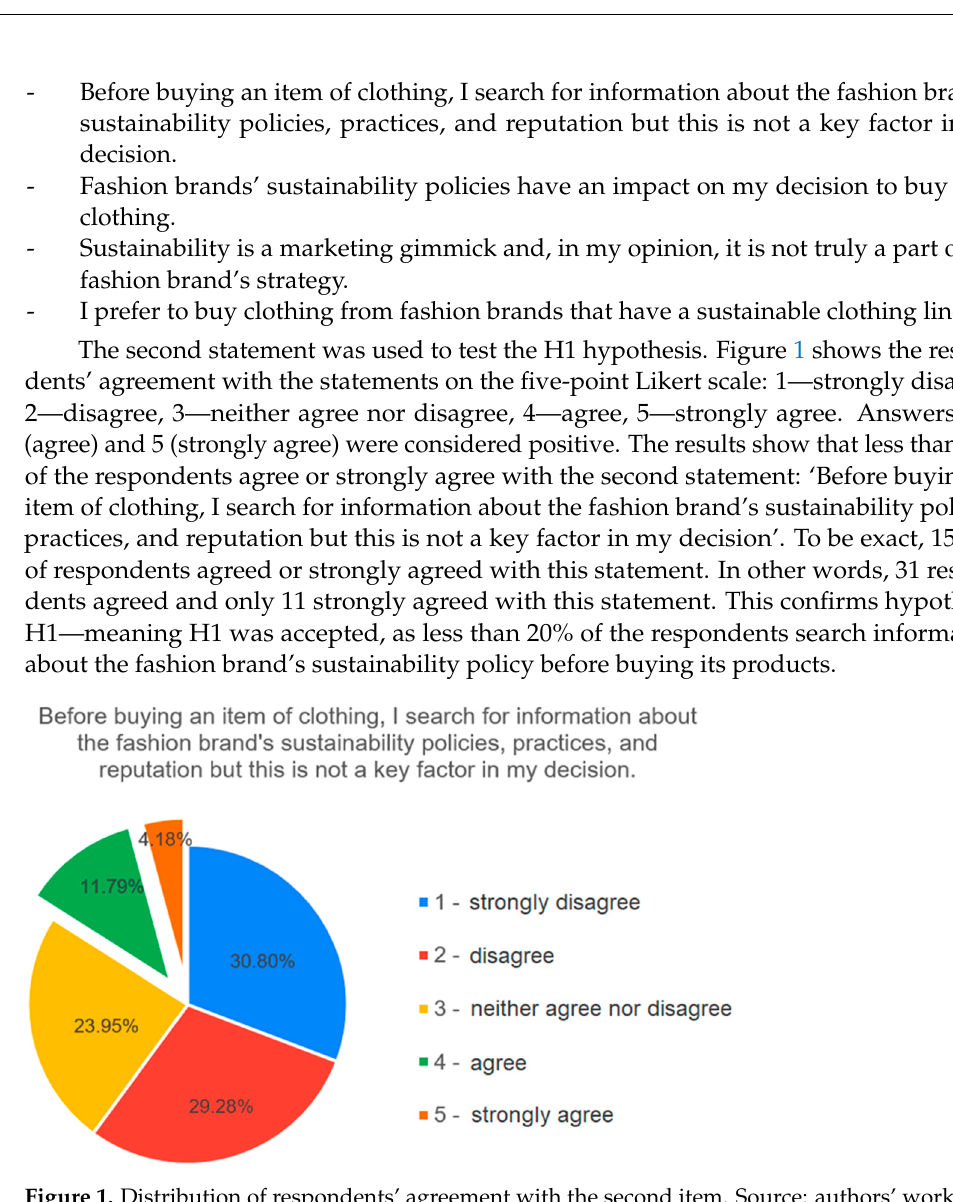
Figure 1. Distribution of respondents’ agreement with the second item. Source: authors’ work.